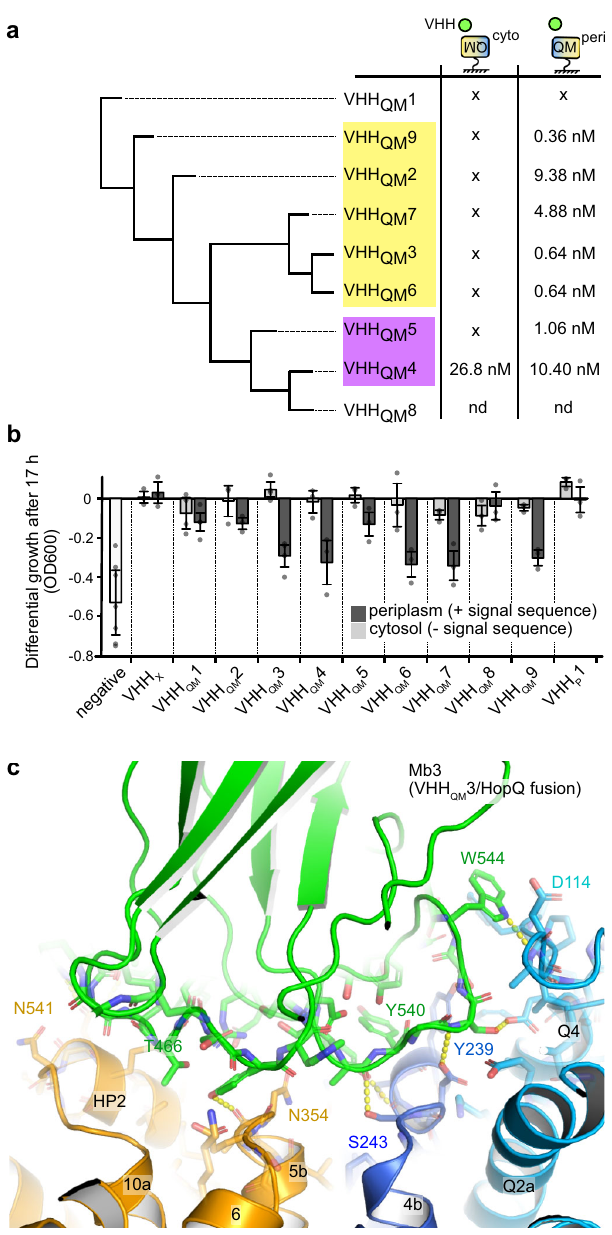
Fig. 3 Characterization of TRAP transporter-speci fi c VHHs and inhibition of transport in vivo. a A hierarchical clustering tree of nine HiSiaQM- speci fi c VHHs, based on PBLAST e-values as the distance matrix for tree building. The binding af fi nities of the VHHs, determined from SPR experiments are given (x: no binding detected; nd: not determined, since no clear binding detected in size-exclusion chromatography). VHHs that bind to HiSiaQM mutually exclusively are grouped by yellow and violet